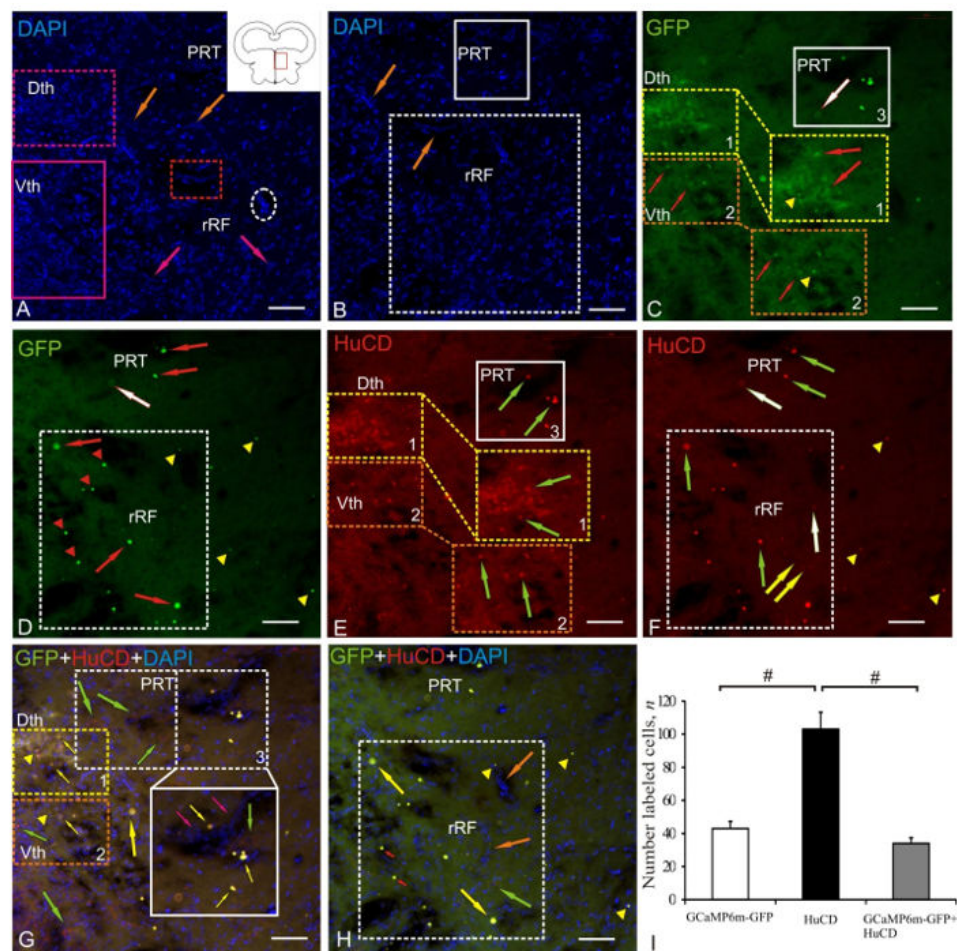
Figure 3. Z-stacks representing HuCD immunolabeling in the thalamus of juvenile chum salmon, O. keta , at 1 week after a single injection of recombinant AAV into the mesencephalic tegmentum area. ( A ) DAPI staining, the pictogram shows the thalamus area (in a red rectangle), rectangles outline clusters of small rounded nuclei, Dth—dorsal thalamus, Vth—ventral thalamus, DAPI-stained microvessel fragments (orange arrows), elongated nuclei (pink arrows), forming heterogeneous complexes with oval cells (outlined by red rectangle), as well as aggregations of nuclei (outlined by white dotted oval), forming parenchymal neurogenic niches. ( B ) DAPI-stained clusters of nuclei (outlined by white square) forming a complex of pretectal nuclei (PRT), ventral in the dotted square are thalamic zones of the reticular formation (rRF). ( C ) Expression of green fluorescent protein GFP in cells of the periventricular thalamus, an aggregation of GFP+ cells (red arrows) and granules (yellow arrowheads) in Dth (population № 1 outlined by yellow dashed rectangle), in Vth (population № 2 outlined by orange dotted rectangle), in PRT (population № 3 in the white rectangle), a weakly GFP-labeled cell (white arrow). ( D ) GFP expression in PRT cells (green arrows), rRF nuclei (red arrowheads), and granules (yellow arrowheads). ( E ) Immunofluorescence of the HuCD protein in neurons of the periventricular thalamus (green arrows), other designations are as in ( C ). ( F ) HuCD in PRT neurons (green arrows—intensely labeled, white—weakly labeled), in rRF (yellow arrows indicate weakly labeled differentiated neurons, yellow arrowheads indicate small neurons). ( G ) Superposition of three channels of DAPI/GFP/HuCD staining in cells (yellow arrows); Dth and Vth (populations № 1, 2), granules (yellow arrowheads), GFP–/HuCD+ neurons (red arrows), in PRT (population № 3) HuCD+/DAPI+/GFP– large neurons (green arrows) adjoined the population of GFP+/HuCD+ cells and nuclei on one side (in a white dotted rectangle), and on the other, to the vascular sinus (inset, outlined by white rectangle) with migration patterns (pink arrows). ( H ) In rRF, DAPI/GFP/HuCD colocalization patterns (outlined by white dotted square) in GFP+/HuCD+ cells (yellow arrows), nuclei (red arrows), and granules (yellow arrowheads). ( I ) Results of ANOVA analysis showing the comparative distribution of labeled cells and nuclei (M ± SD, where M is the mean and SD is the standard deviation) in the thalamus of juvenile chum salmon, O. keta . Significant intergroup differences (# < 0.05) were found between the groups of GCaMP6m-GFP+ and GCaMP6m-GFP+/HuCD+ cells and the groups of HuCD+ and GCaMP6m-GFP+/HuCD+ cells ( n = 5 in each